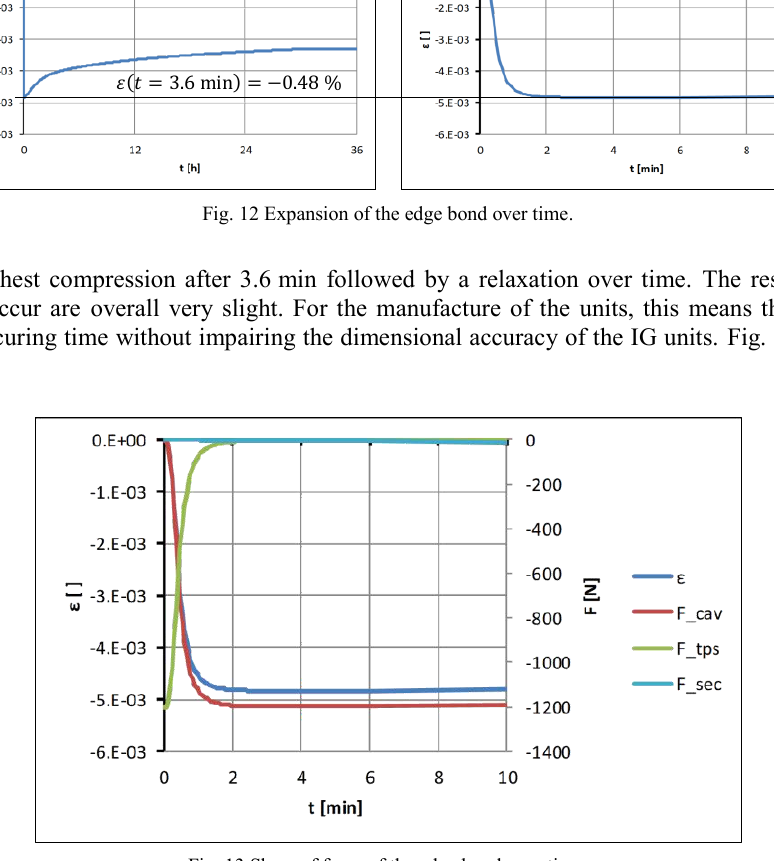
Fig. 13 Share of force of the edge bond over